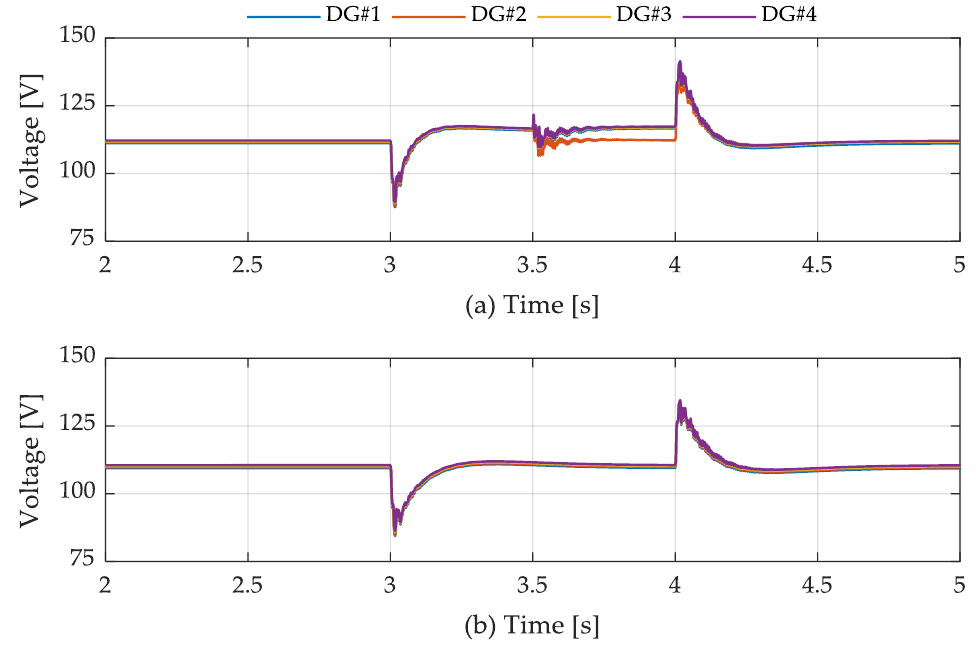
Figure 11. Output voltage of each DG: ( a ) centralized method; ( b ) proposed method.